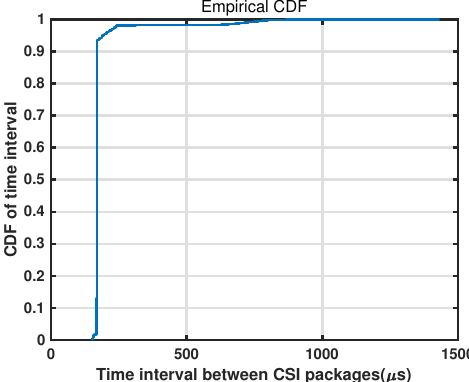
Figure 5. The CDF of time intervals for the received CSI packages.